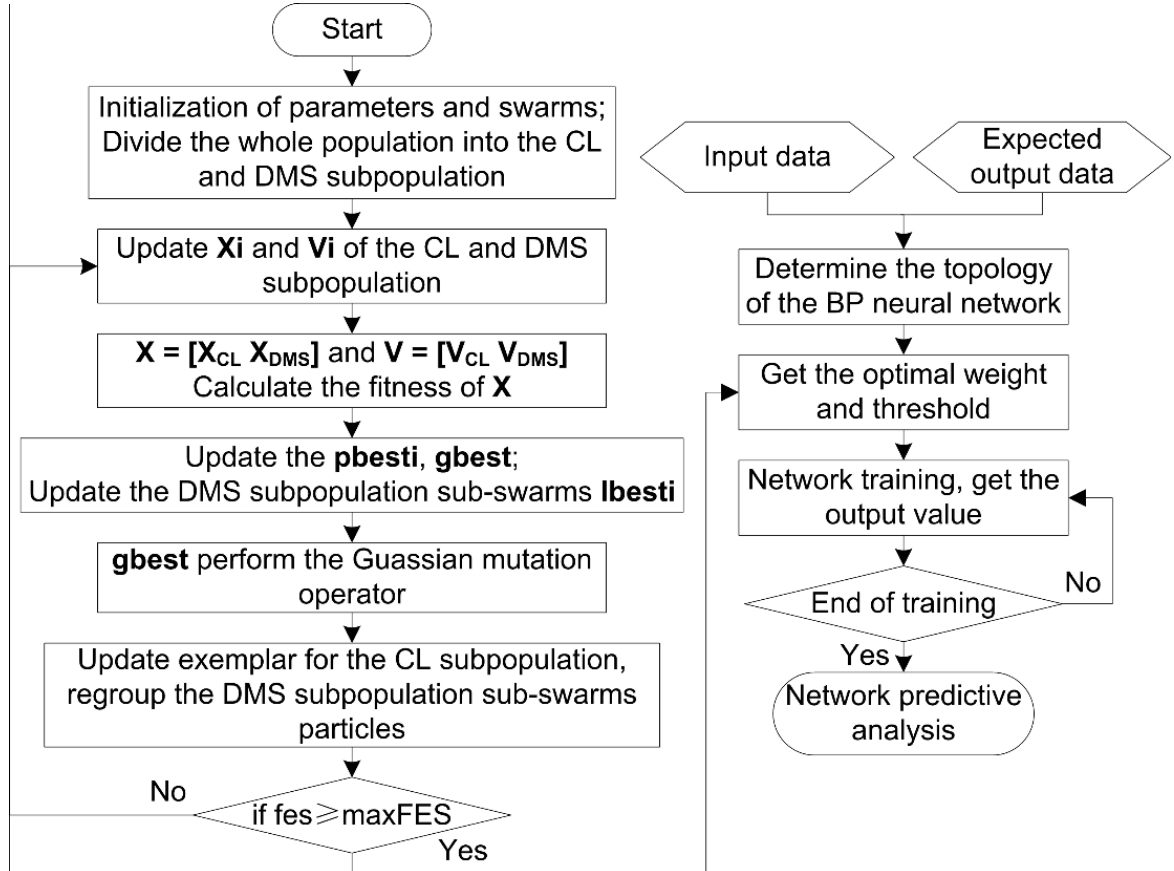
Figure 1. Flow chart of the HPSO-BP algorithm (CL is the comprehensive learning, DMS is the dynamic multi-swarm, Xi and Vi represent the position and velocity, respectively. pbesti and gbesti represent the historical optimal position of the i th particle and the best position of the entire population, respectively. lbesti is local best experience, fes is the number of iterations. HPSO-BP represents the BP neural network model optimized by HCLDMS-PSO algorithm).